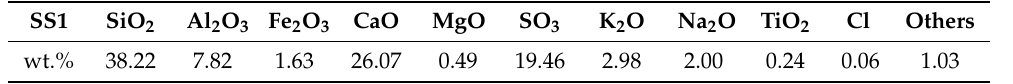
Table 3. Oxide composition (wt.%) of SS1 supersulfated